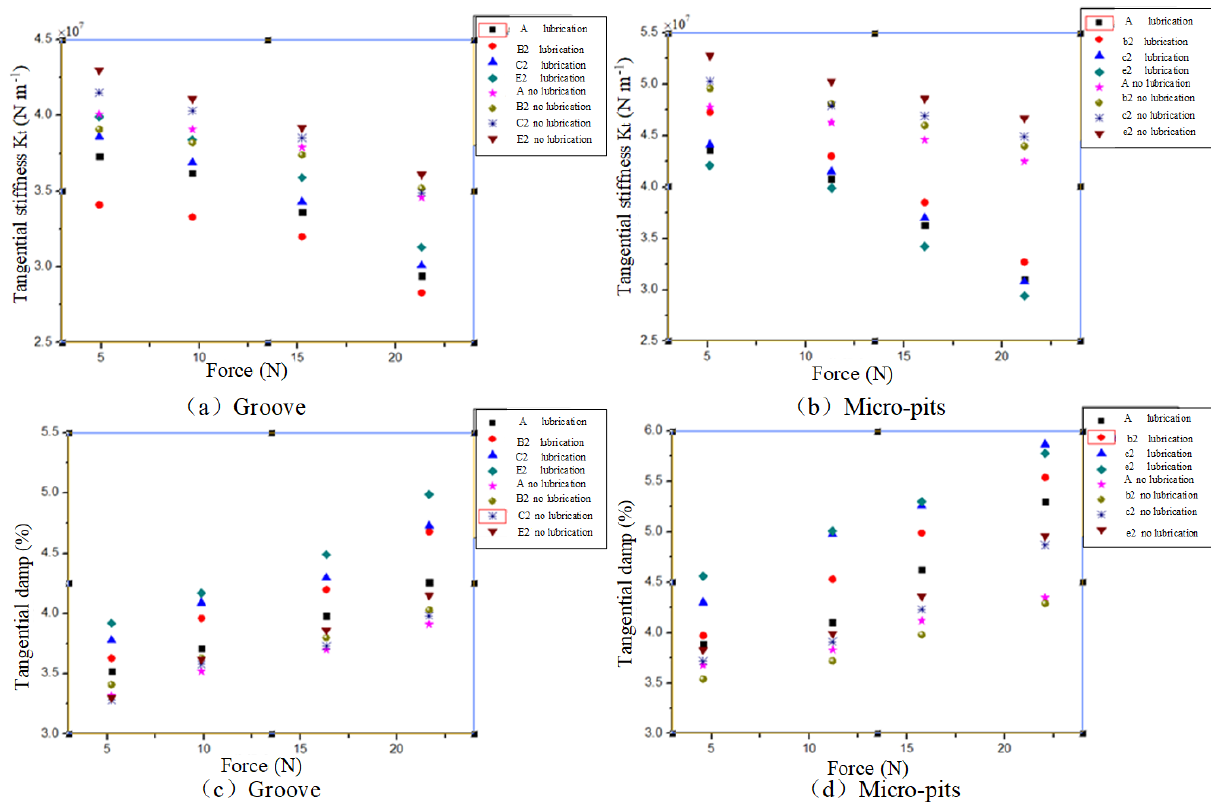
Figure 22. (a, b) The impact of lubrication on the tangential stiffness (groove and micro-pits). (c, d) The impact of lubrication on the tangential damp (groove and